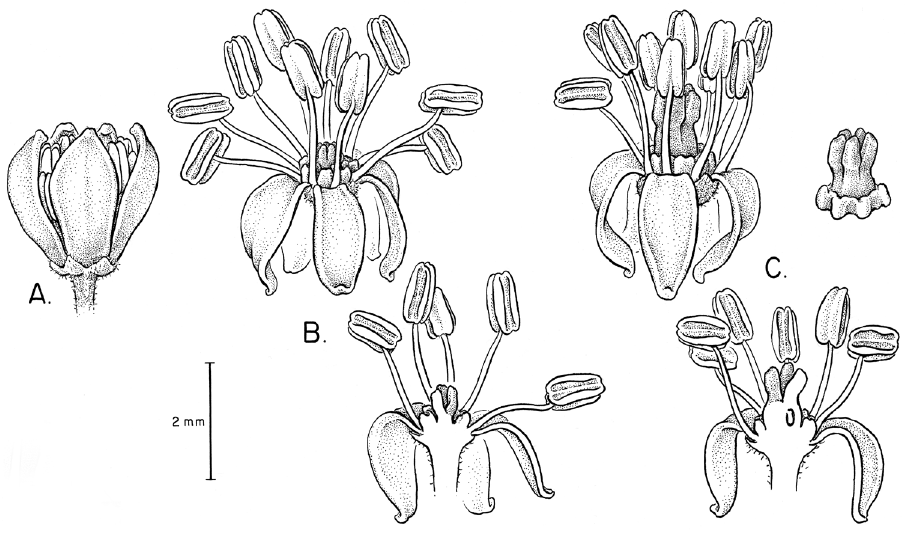
Figure 11. Flowers of Spondias mombin. A Opening bud B Flower at anthesis (top) and longisection at center of same C Flower post-anthesis with pistil further developed (top), longisection at center of same (bottom), and disk and pistil. A–C from Rusby & Squires 102 (NY).